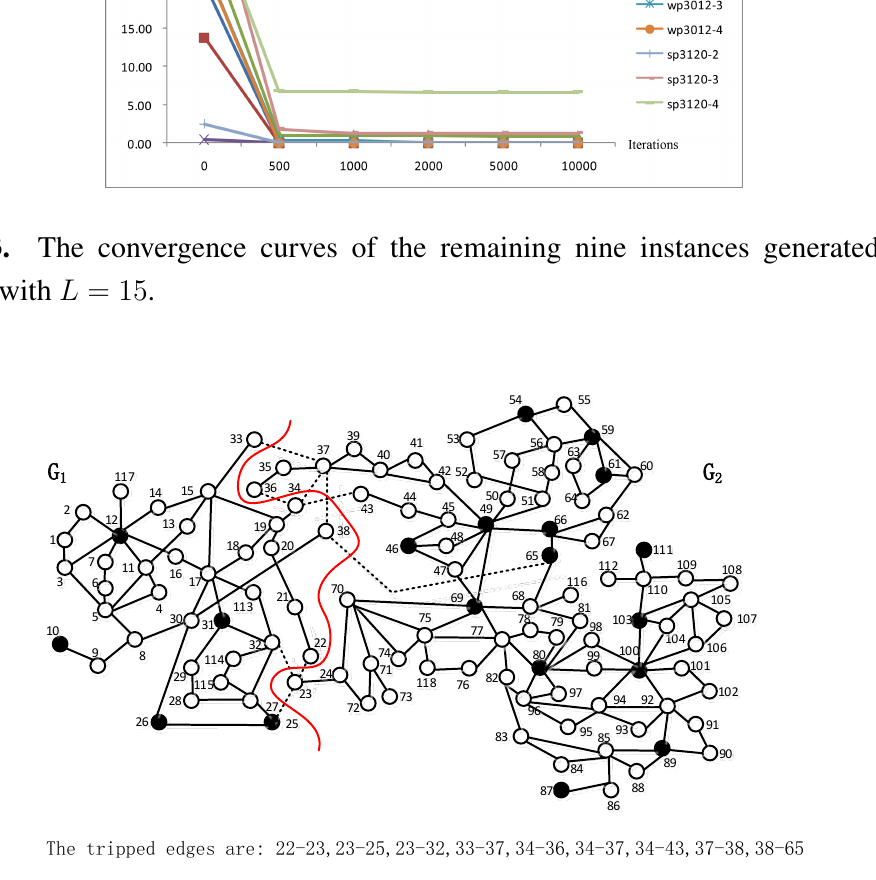
Figure 14. The pictorial result of instance ieee118-2 .